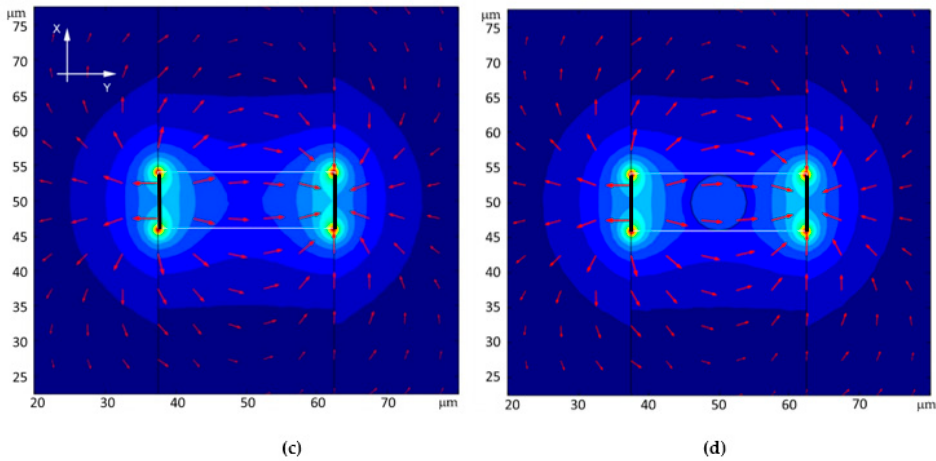
Figure 8. Electric field strength in the detection volume with and without 8 μ m RBC in 25 μ m microfluidic channel for; ( a , b ) 1D IDC ( c , d ) 2D PPC.